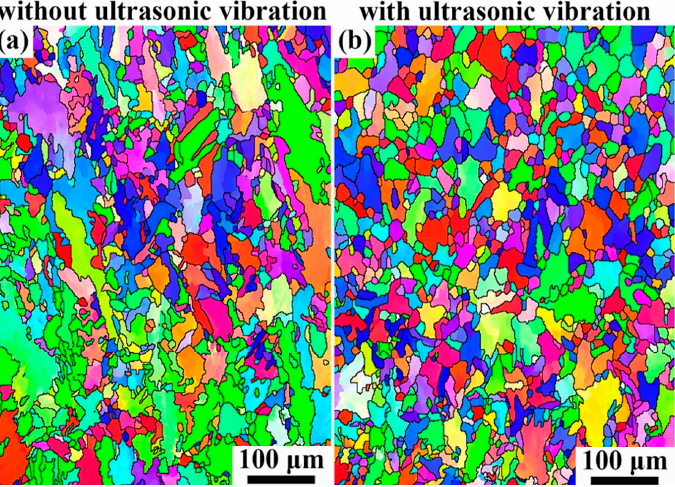
Figure 7. Inverse pole figure (IPF) orientation maps depicting grain structures along the building direction (z) for the austenitic phase in samples: ( a ) no additional ultrasonic vibration; ( b ) additional ultrasonic vibration, reproduced or adapted from [100], with permission from Elsevier, 2021.